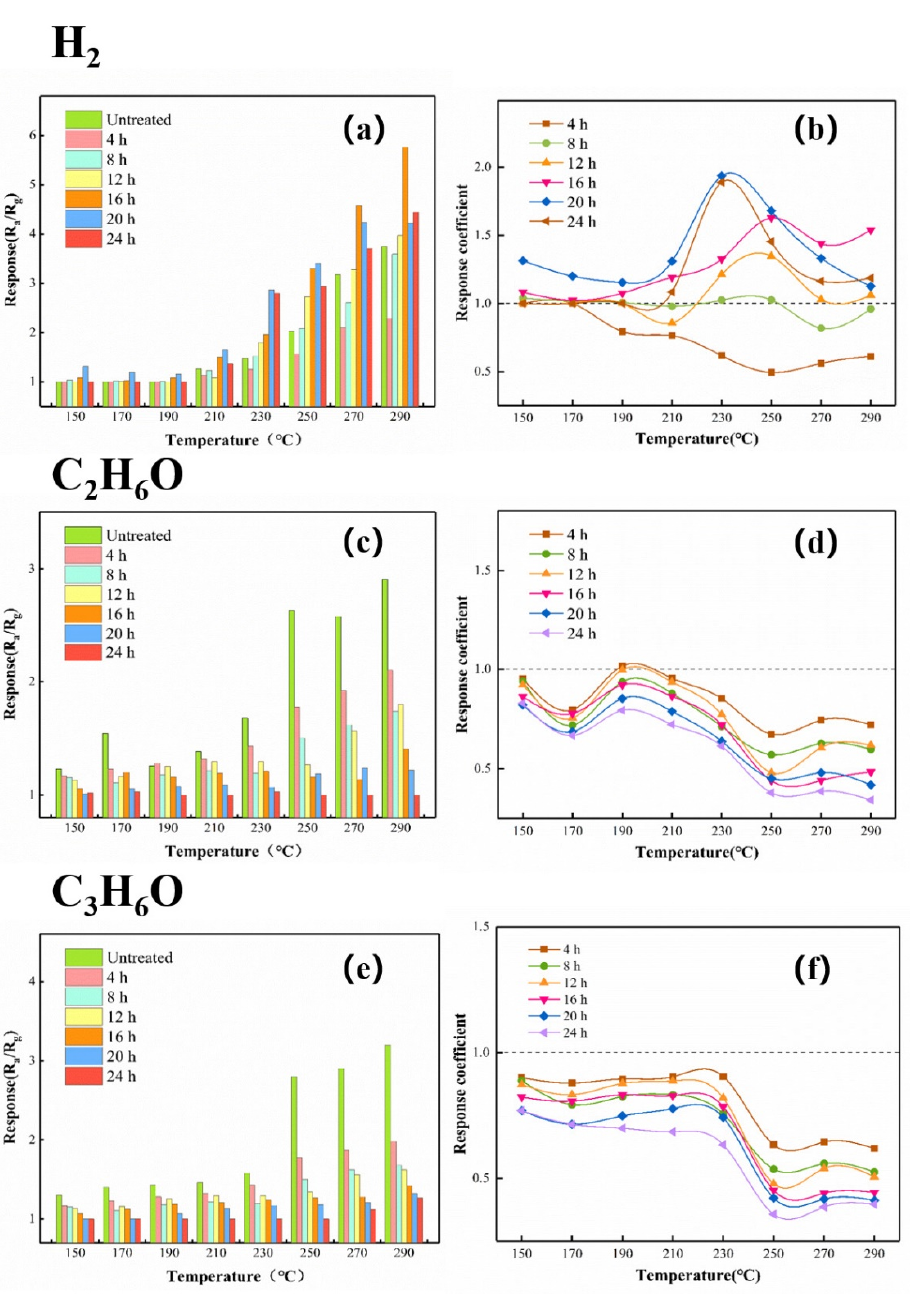
Figure 14. The responses and response coefficients of the gas sensors to different gases: ( a , b ) 1000 ppm H 2 , ( c , d ) 100 pm C 2 H 6 O, and ( e , f ) 50 ppm C 3 H 6